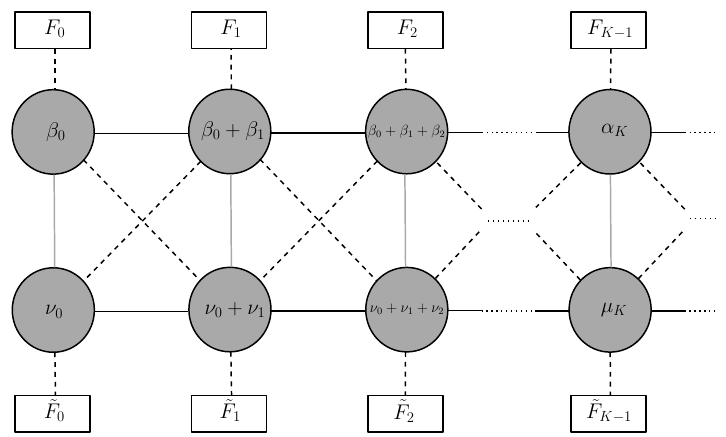
Figure 3 . A generic quiver (cid:12)eld theory whose IR is dual to the holographic background de(cid:12)ned by the functions in (3.4){(3.5). As before, the solid black line represents a (4 ; 4) hypermultiplet. The grey line represents a (0 ; 4) hypermultiplet and the dashed line represents a (0 ; 2) Fermi multiplet. N = (4 ; 4) vector multiplets are the degrees of freedom in each gauged